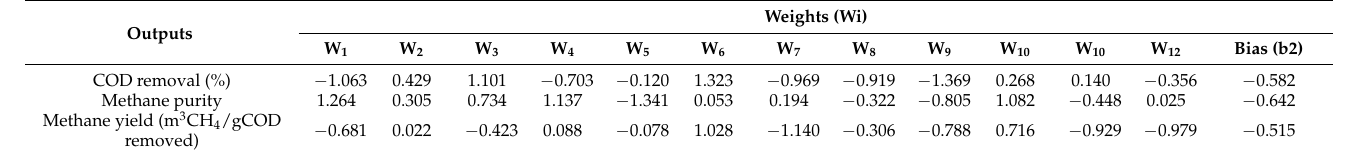
Table A2. Output weights and biases of the ANN model for anaerobic digestion.